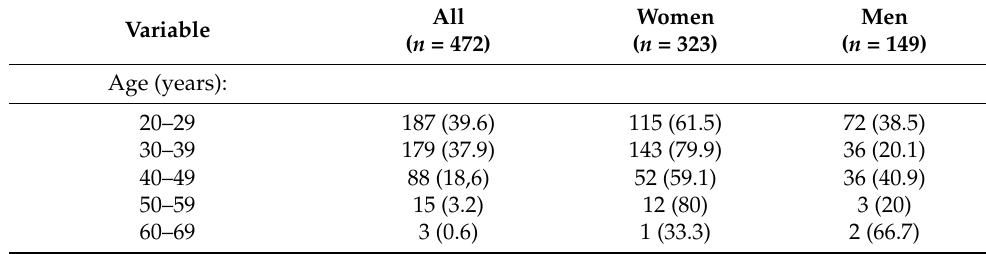
Table 1. Participants’ sociodemographic and professional characteristics [data provided: n (percentage)].